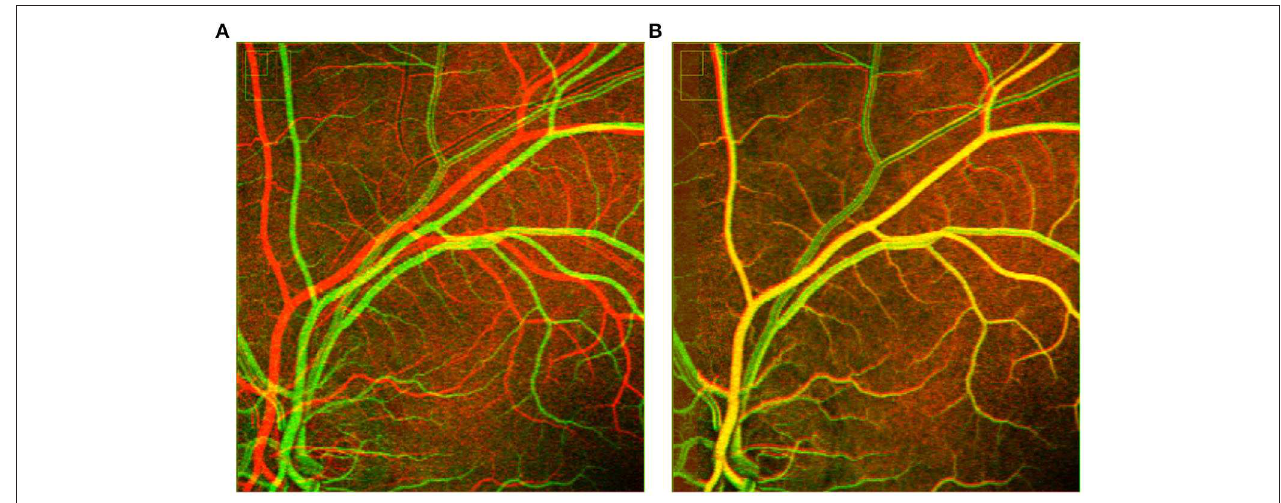
FIGURE 10 | Overlapping two successive frames shows rigid registration (A) fails with grayscale images and (B) successful with binary images.